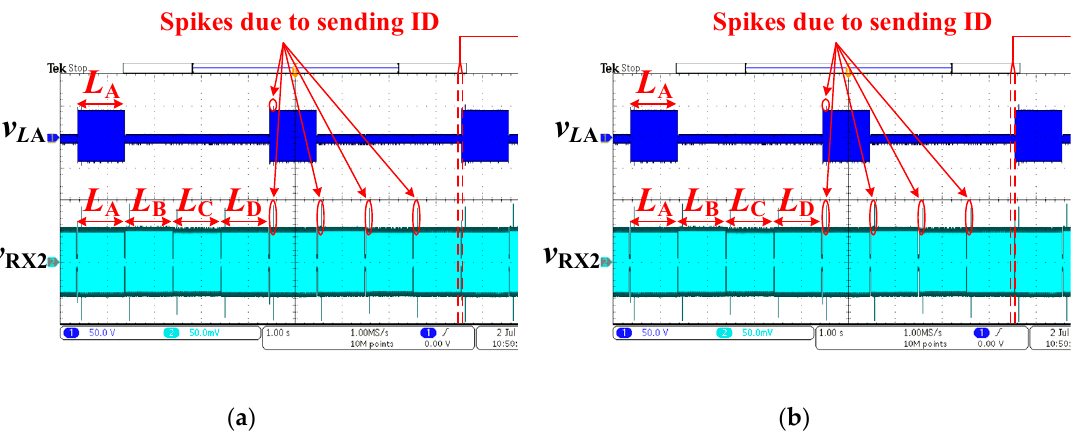
Figure 14. ( a ) Receiving waveforms of secondary signal extractor L RX2 ; ( b ) amplitude measurement waveforms when L A is enabled.